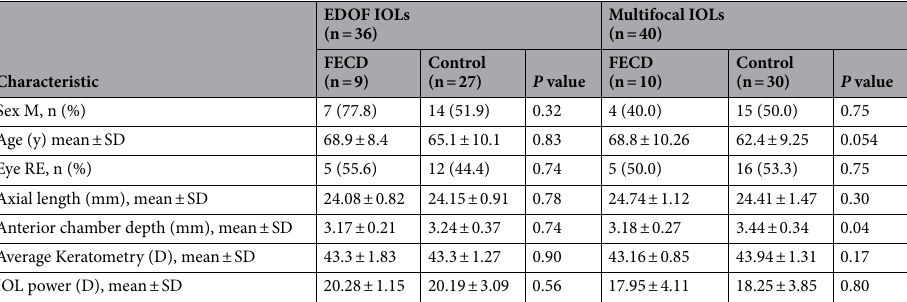
Table 2. Baseline characteristics of the EDOF and multifocal IOLs subgroups. FECD Fuchs endothelial corneal dystrophy; IOLs intraocular lenses; M male; n number; y years; D diopters. Values are presented in mean ± SD, unless specified otherwise.